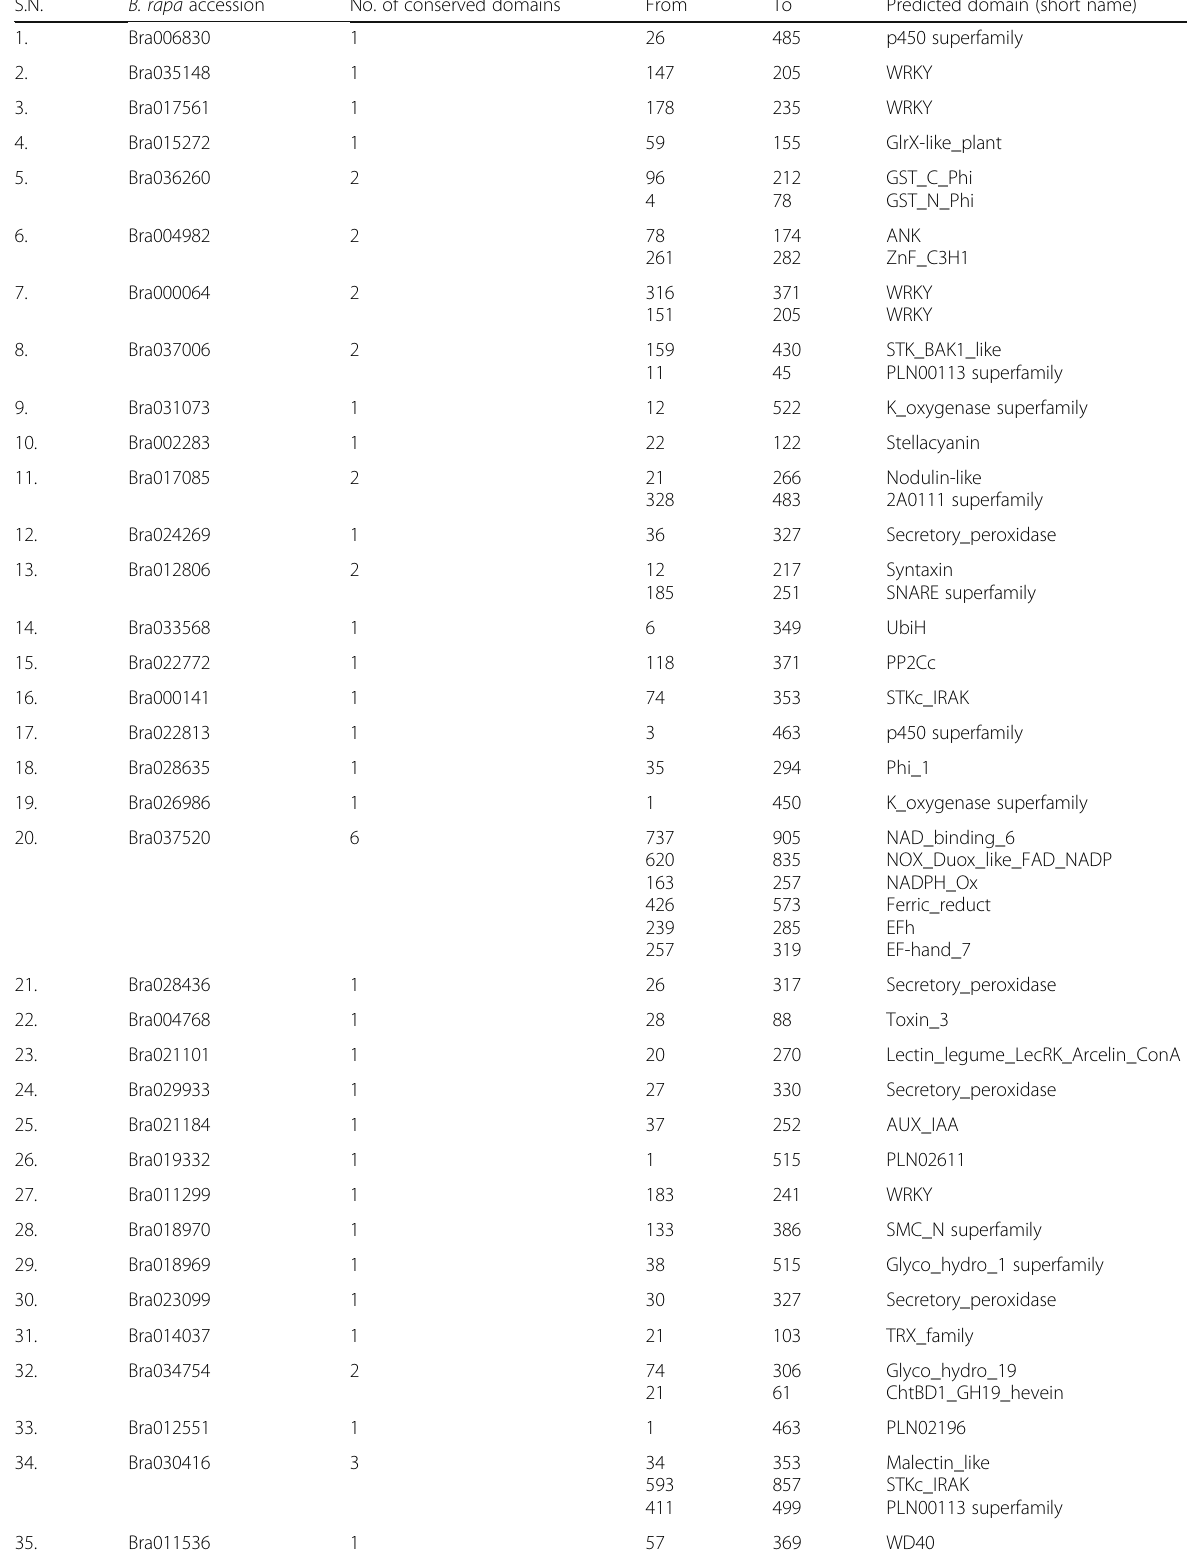
Table 5 Predicted conserved domains in identified upregulated Brassica rapa sequences with their positions under contrast ETMC